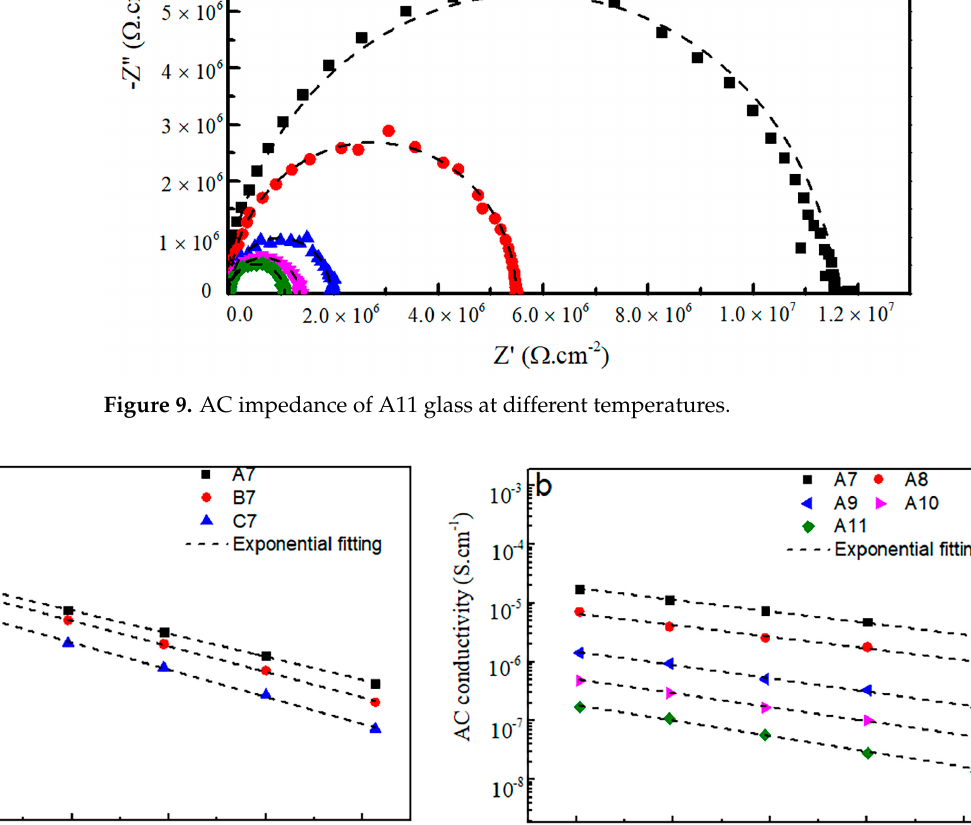
Table 2. Electrical conductivities σ , resistivity δ , activation energy E a , pre-exponential factor σ 0 of A2–A11, B7, and C7 glasses (T = 293 K).